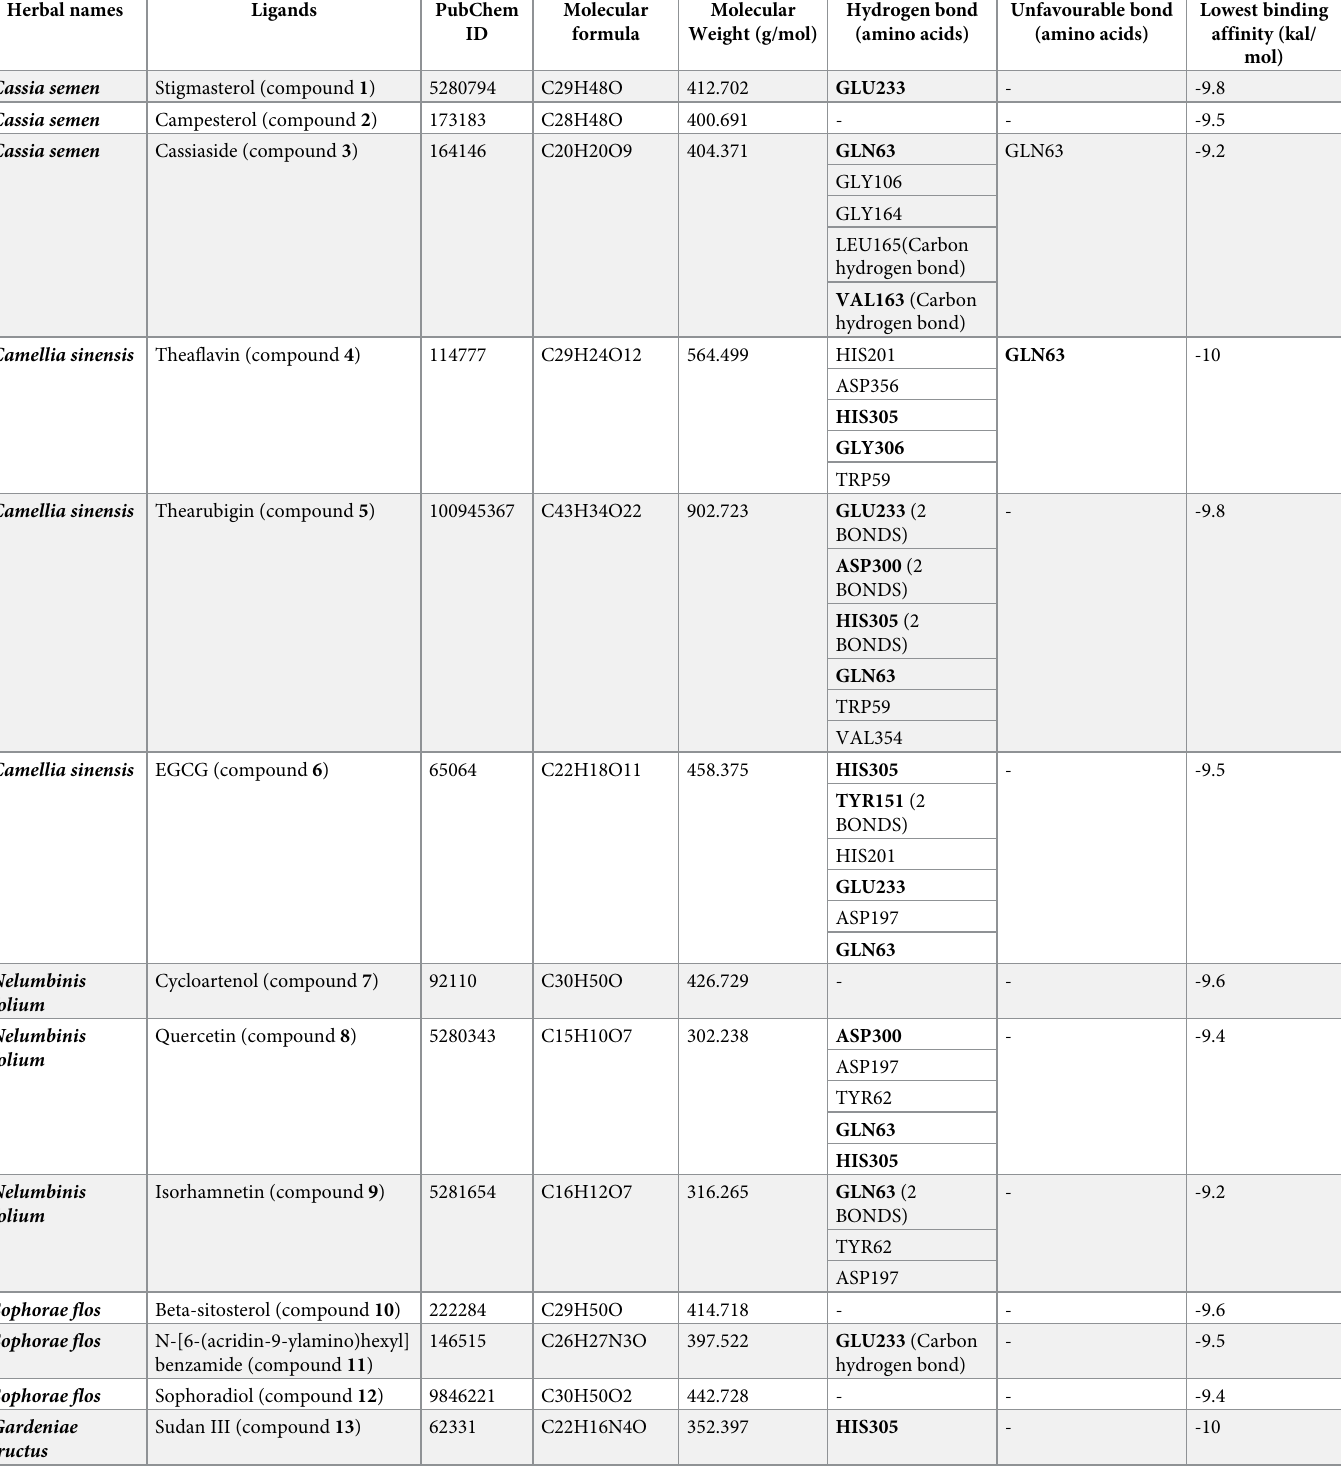
Table 1. Top 3 ligands predicted from each herb with the strongest binding affinity and their bonds with IOSE. Herbal